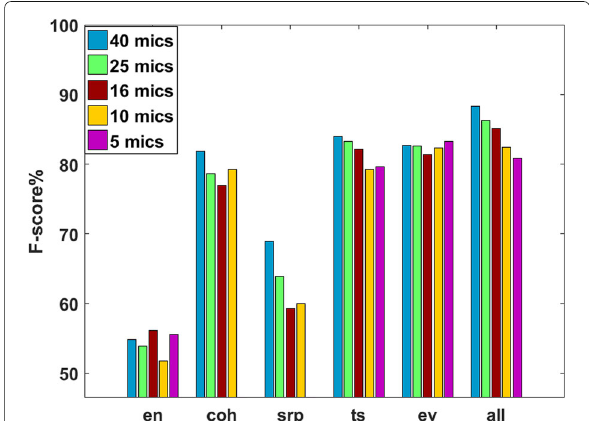
Fig. 13 Performance of the room discriminant features of Section 5.1 for the speech-inside vs. speech-outside classification task with ground-truth segmentation on the DIRHA-sim test set, using various numbers of microphones (en, energy-based; coh, coherence-based; srp, SRP-based; ts, spectrogram texture smoothness; ev, envelope variance; all, intra-room fusion (9)) Inter-room fusion (10) and room-specific SVMs are used